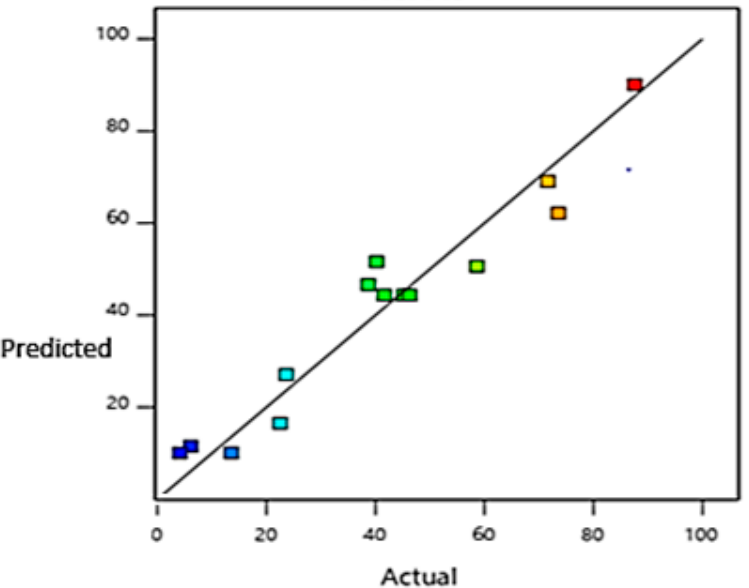
Figure 3. Percentage values of anticipated vs. actual yields.